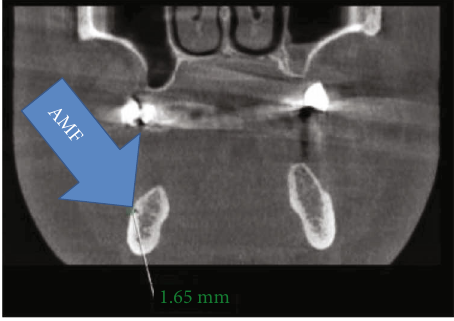
Figure 6: Right AMF at coronal CBCT.